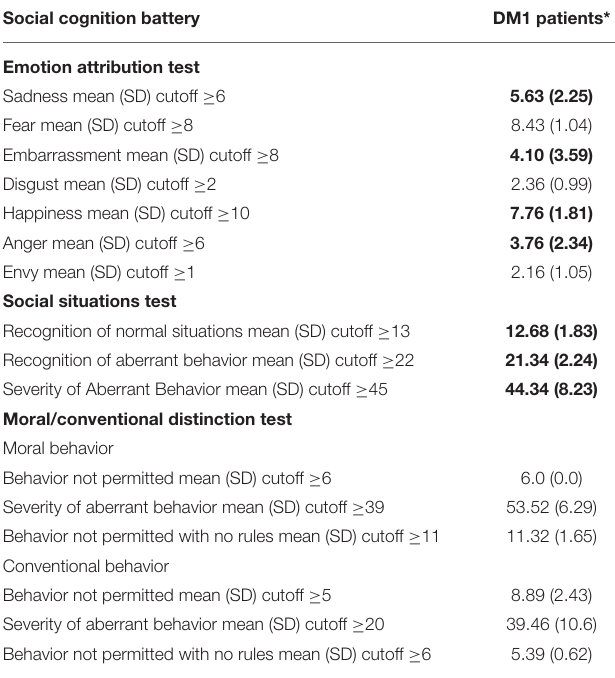
TABLE 3 | Social cognition battery performances obtained by patients with